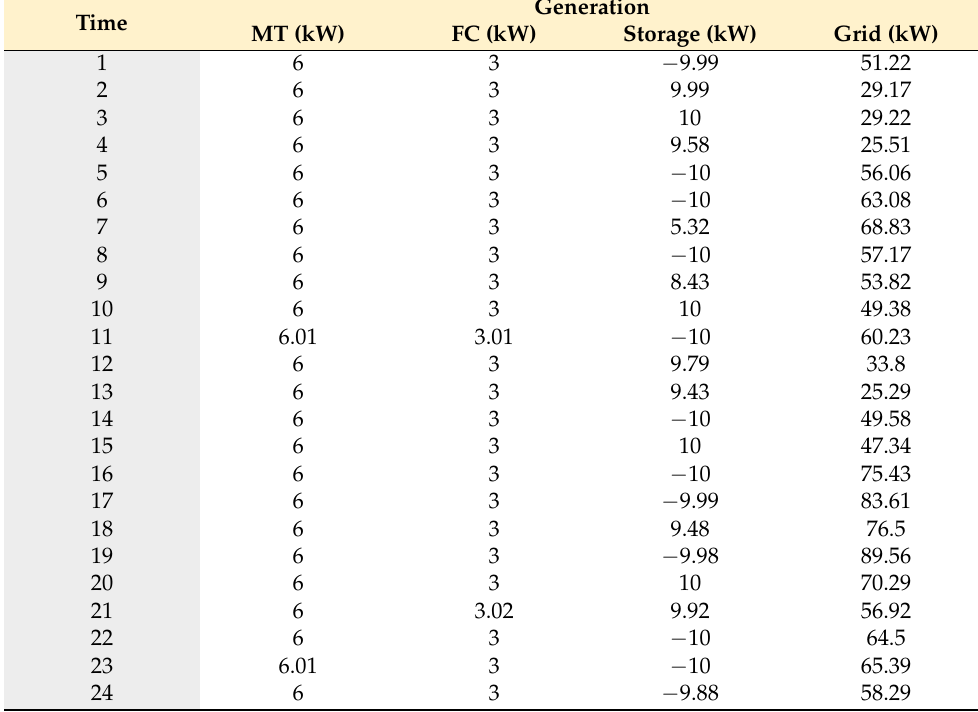
Table 18. Power distribution between sources to reduce pollution without limiting power exchange (total pollution: 136.58